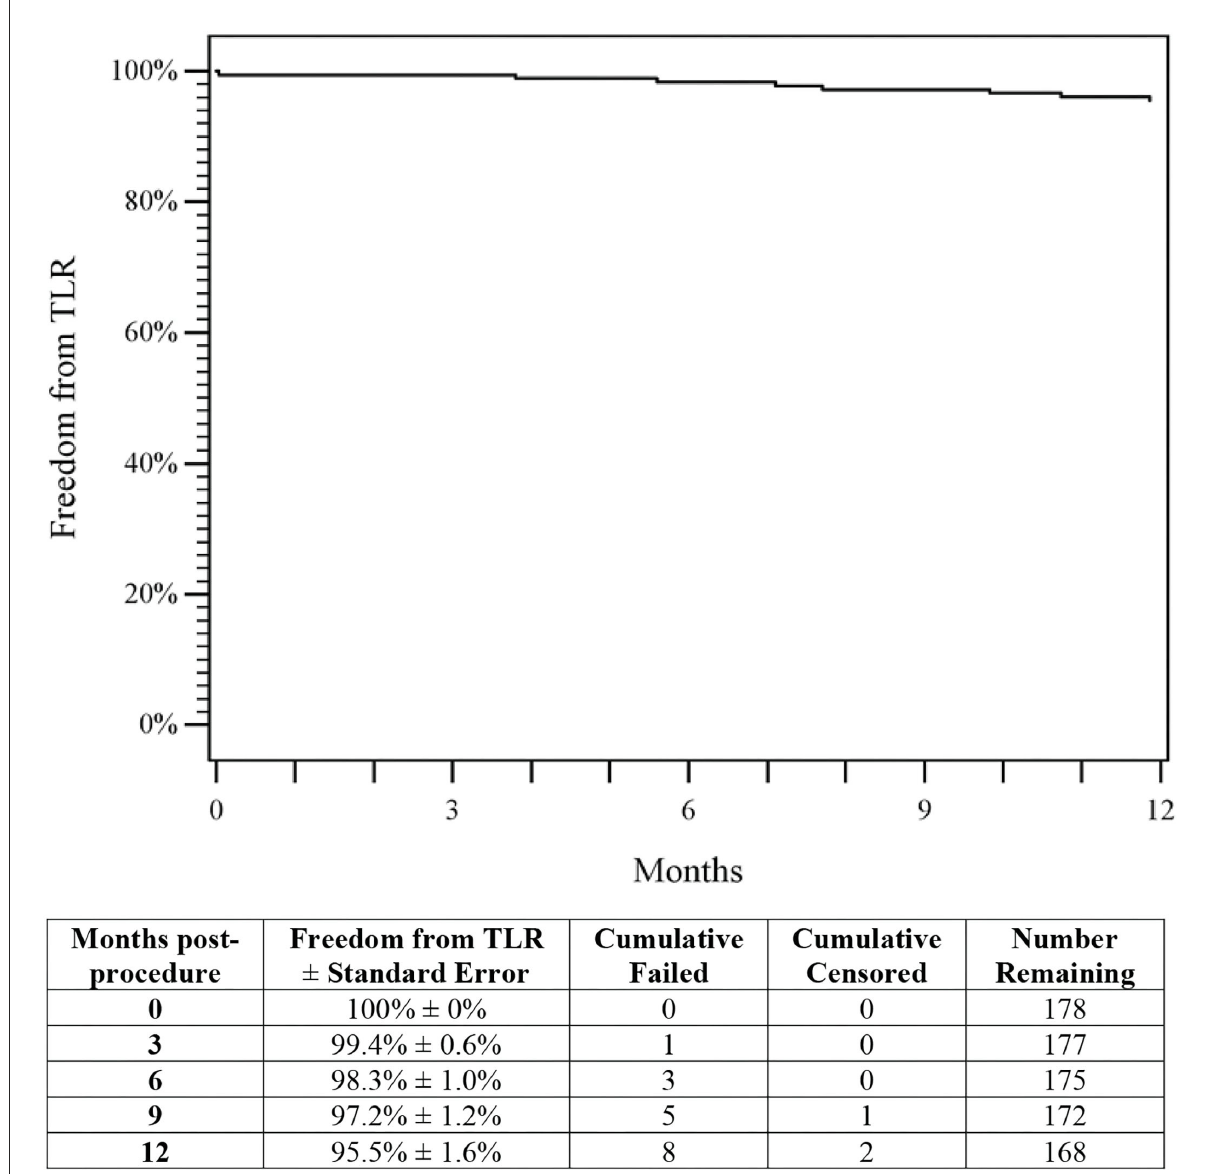
FIGURE4 Freedom from TLR. The Kaplan–Meier curve shows a 95.5% rate of freedom from TLR through 1-year for patients treated with DES. The life table is included. DES, drug-eluting stent; TLR, target lesion